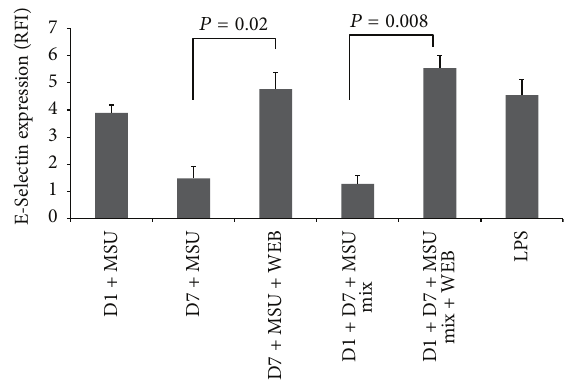
Figure 4: Inhibition of endothelial cell activation by platelet activating factor derived from supernatants from MSU crystal stimulated macrophages. Monocytes or macrophages were cultured for 1 and 7 days, respectively, and stimulated with MSU